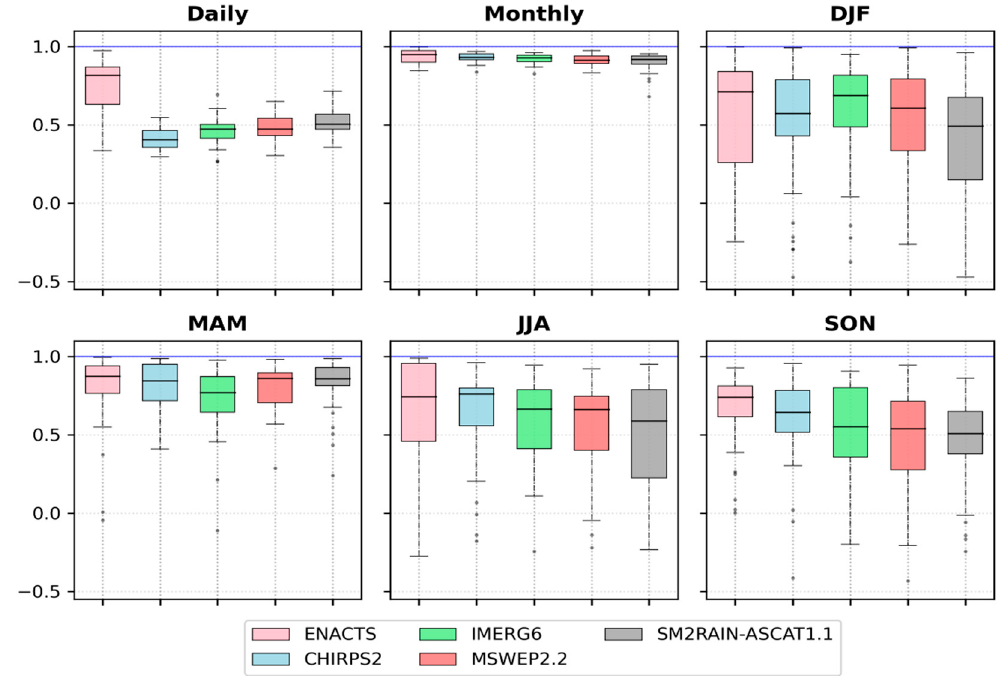
Figure 5. The linear correlation coefficient (r) between different precipitation datasets and gauge observation at different temporal scales. From left to right and up to bottom: daily, monthly, December to February (DJF), March to May (MAM), June to August (JJA), and September to November (SON). The horizontal blue line indicates the optimum value for r.